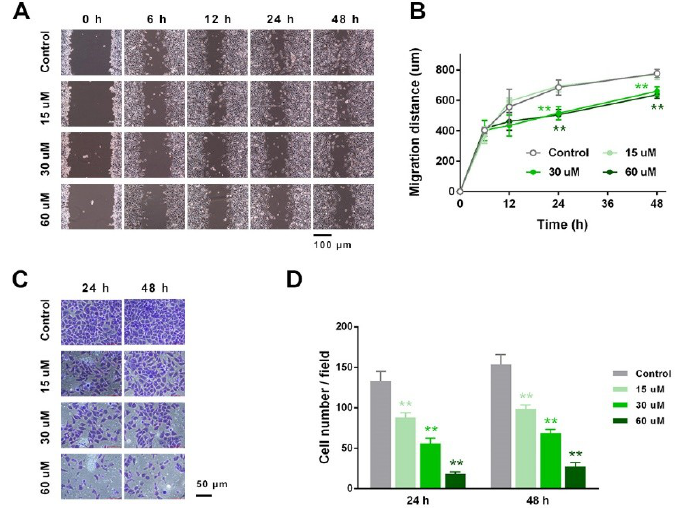
Figure 3. EP suppressed RCC cell migration and invasion. ( A ) Typical photographs of the scratch- assay. ( B ) EP groups displayed much lower migration distance compared with the control group at 24 and 48 h. ( C ) Typical photographs of the invaded cells in the trans-well chamber. ( D ) Number of invaded cells dose-dependently decreased in the EP groups at 24 and 48 h. * p < 0.05; ** p < 0.01, vs. control.